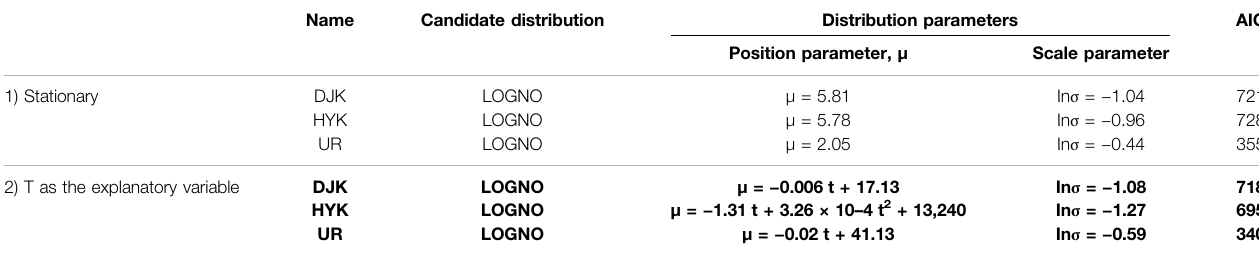
TABLE 4 | Results of marginal distributions fi tting using the GAMLSS model.